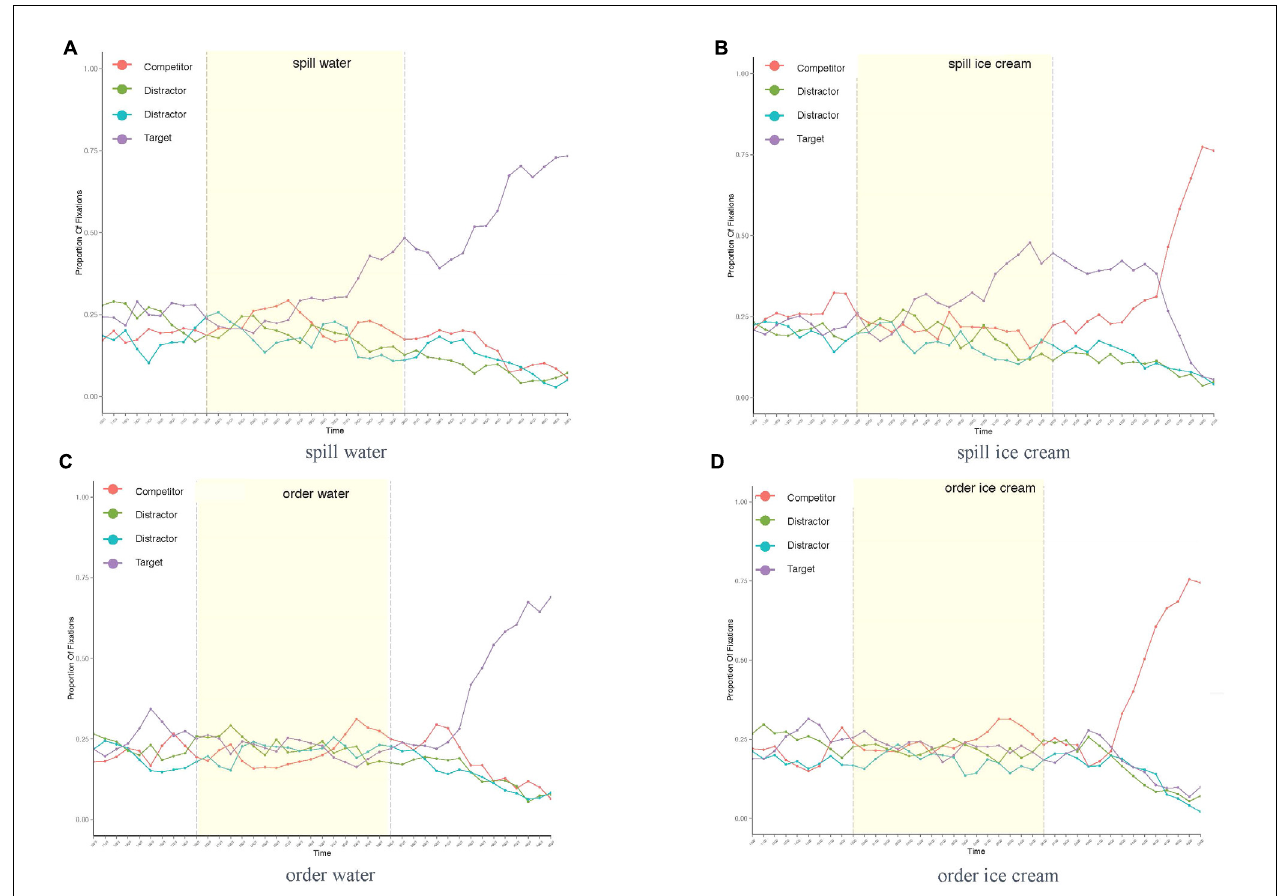
FIGURE 3 | Proportion of fixations across trial length in all conditions of Experiment 3 : spill water (A) , spill ice cream (B) , order water (C) , and order ice cream (D)